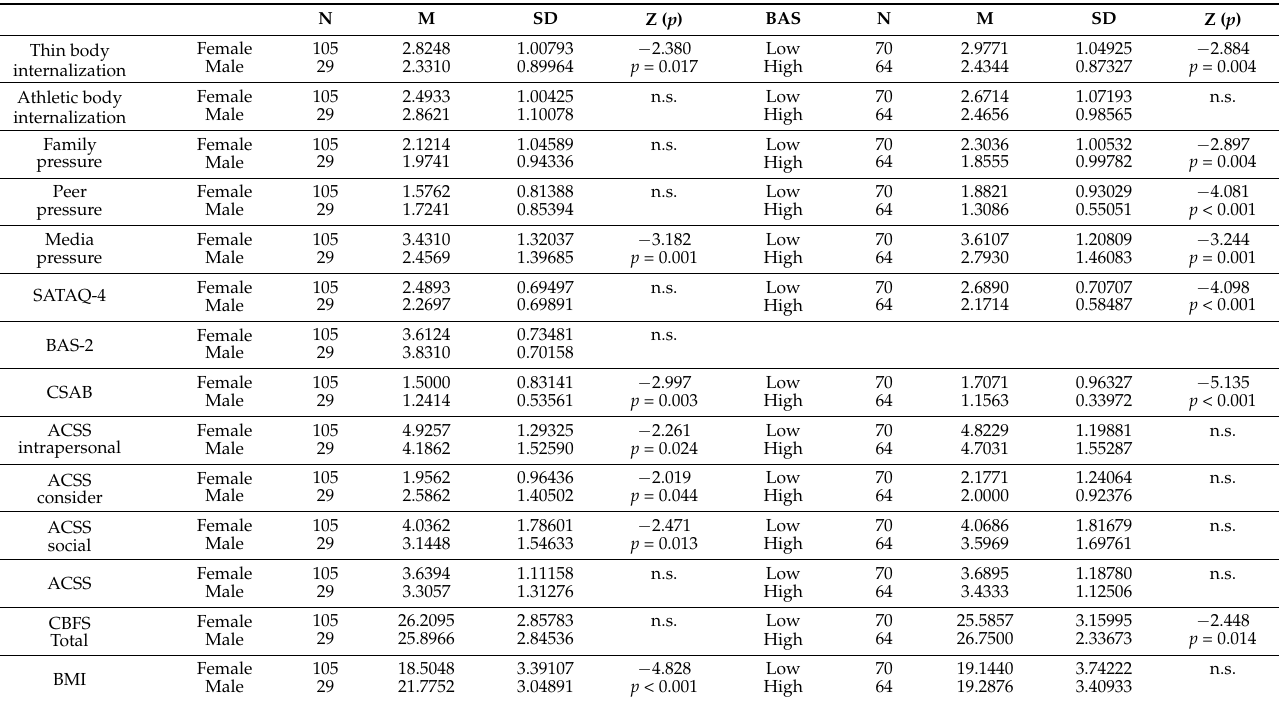
Table 3. Mann–Whitney tests for differences in scale dimensions’ mean scores between gender sub-samples and low versus high levels of body appreciation